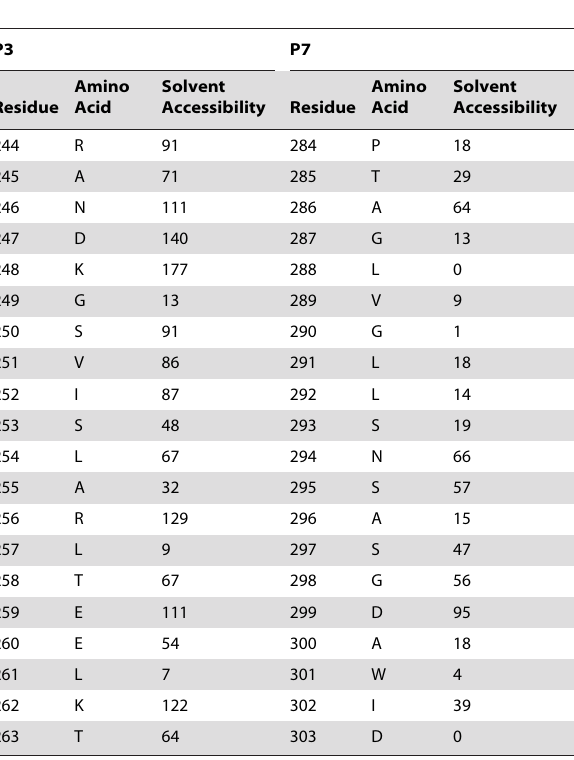
P4 P8 Amino Residue Acid